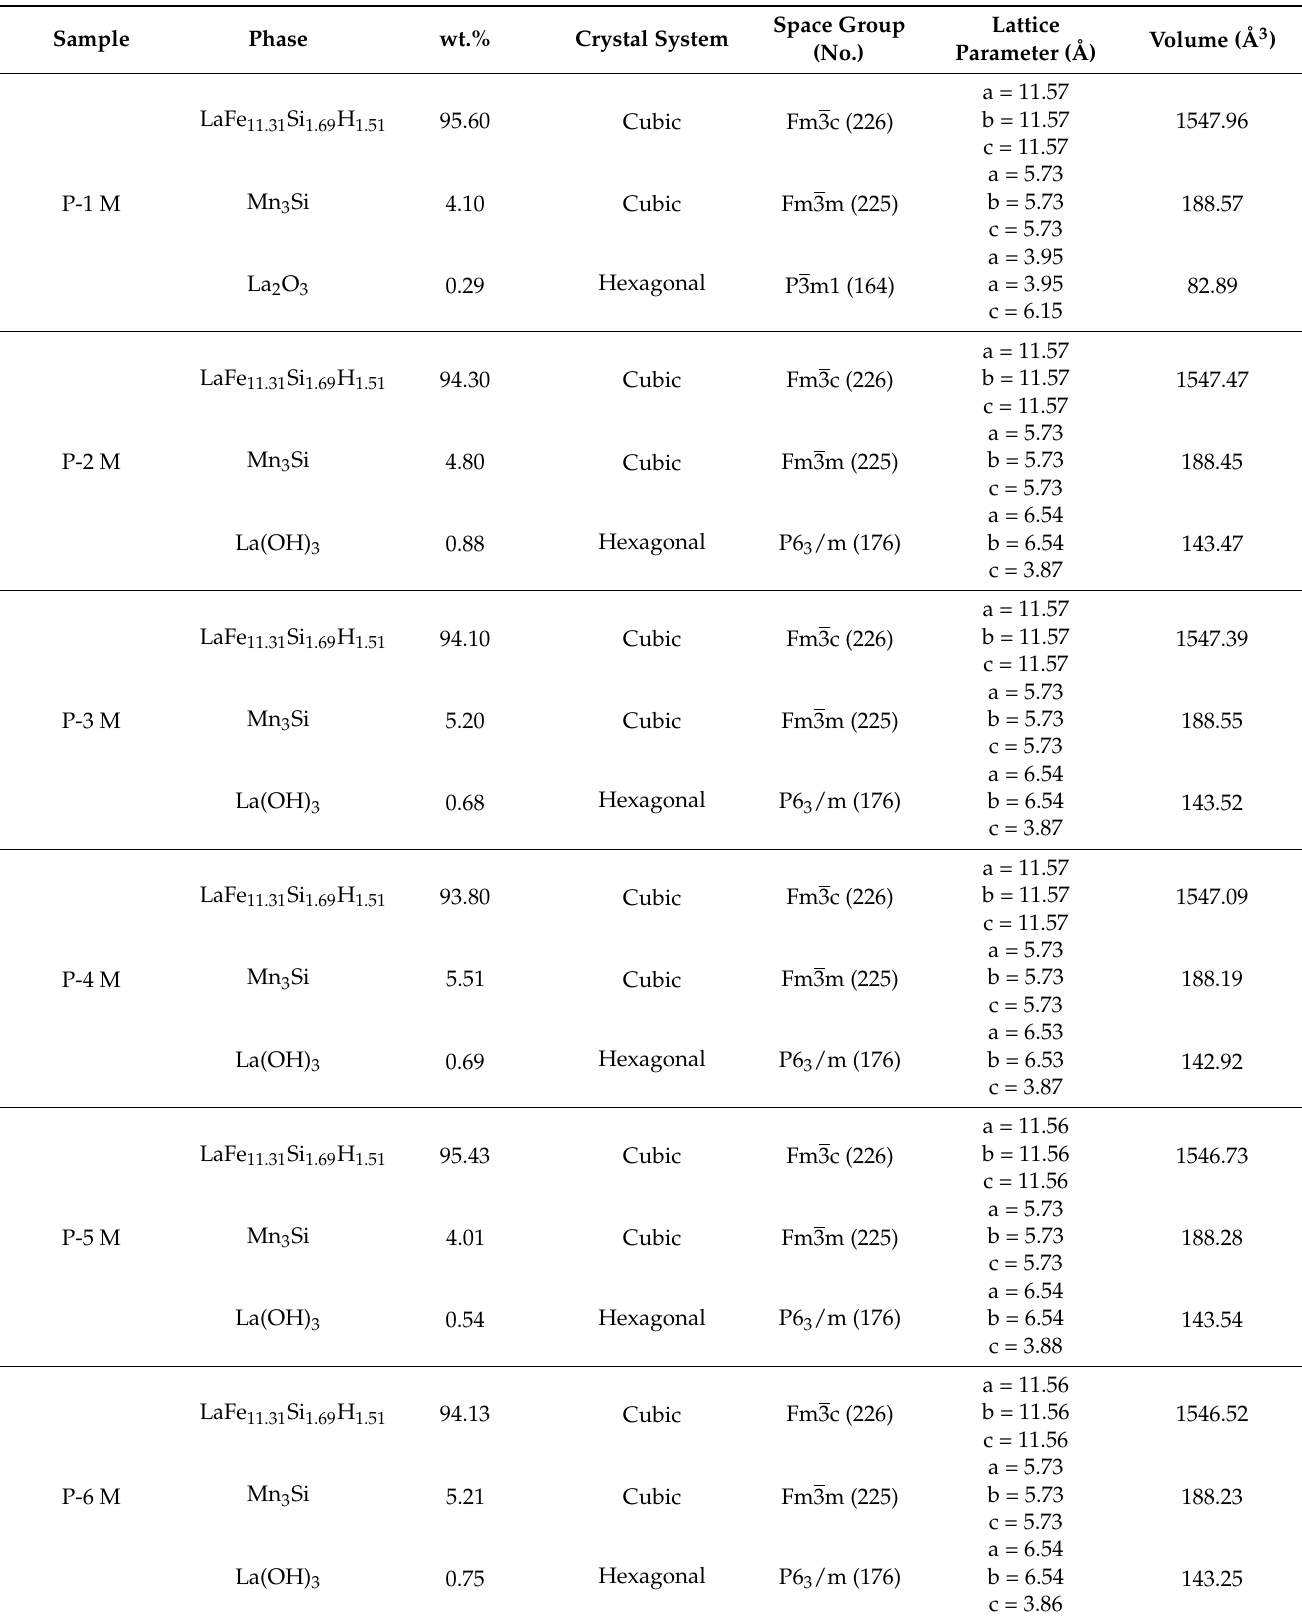
Table A2. Chemical composition of milled (30 min) powders P-1 M–P-6 M. All phase constituents are presented as